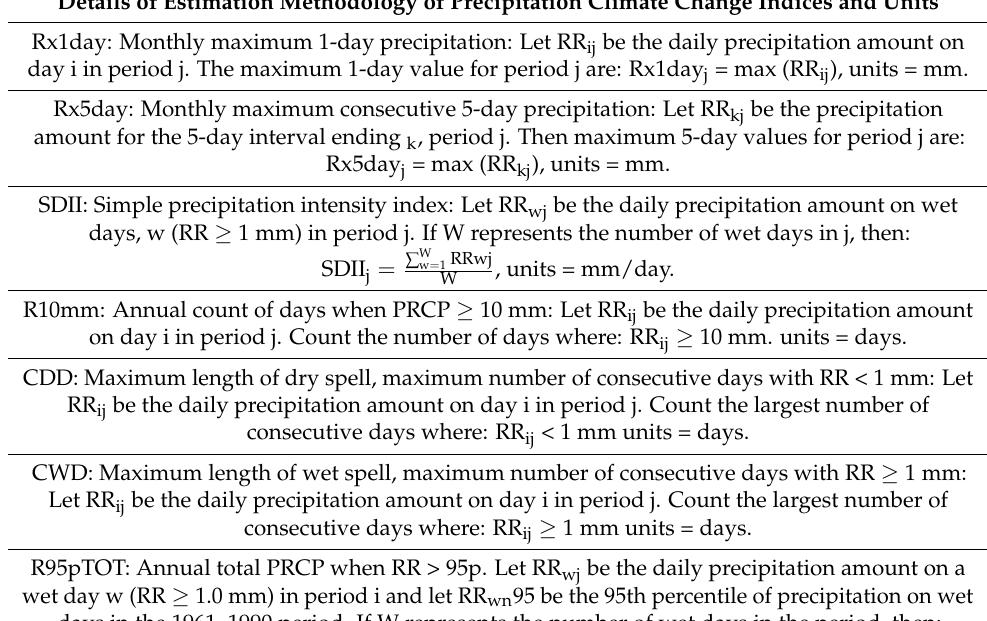
Table 1. Definition, estimation methodology of precipitation climate change indices and their units